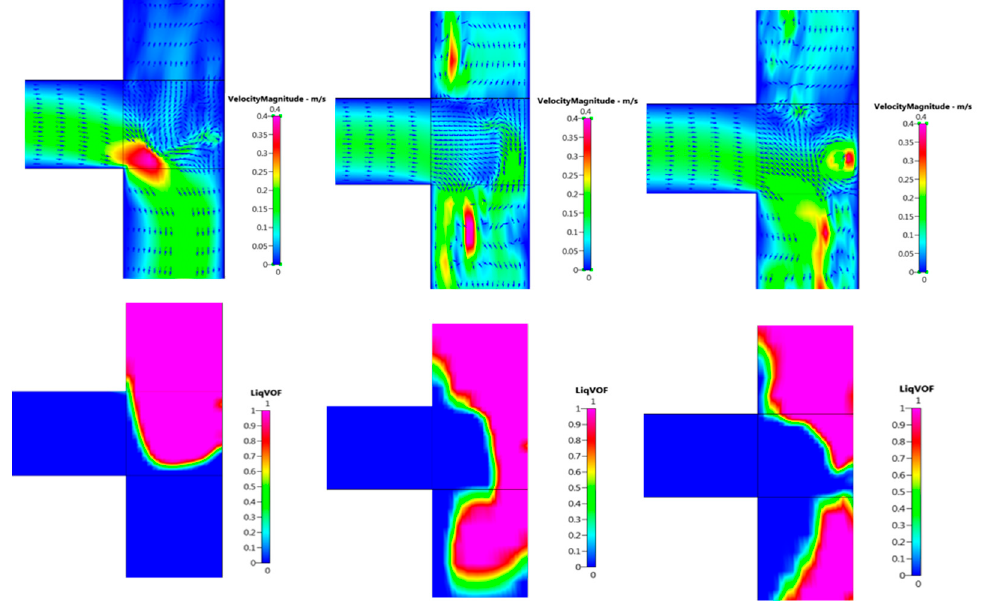
Figure 8. Velocity magnitude contours corresponding to the volume of fluid (VOF) simulation results displaying the bubble detachment and gas column retracting back into the inlet.